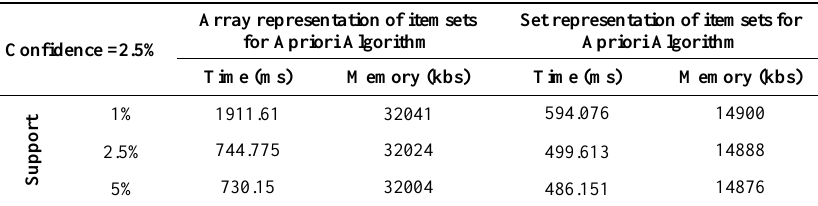
Table 6. The representation of itemset using Array and Set representation for Apriori Algorithm with confidence value=2.5% and Support =1, 2.5, and 5%.